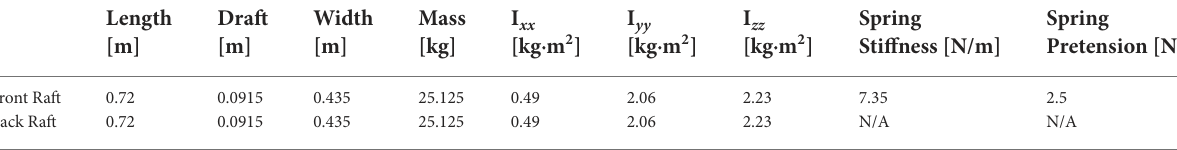
TABLE 1 Dimensions,massandmooringpropertiesofeachraft.Momentofinertia ( I ) isprovidedrelativetothecentreofmass.